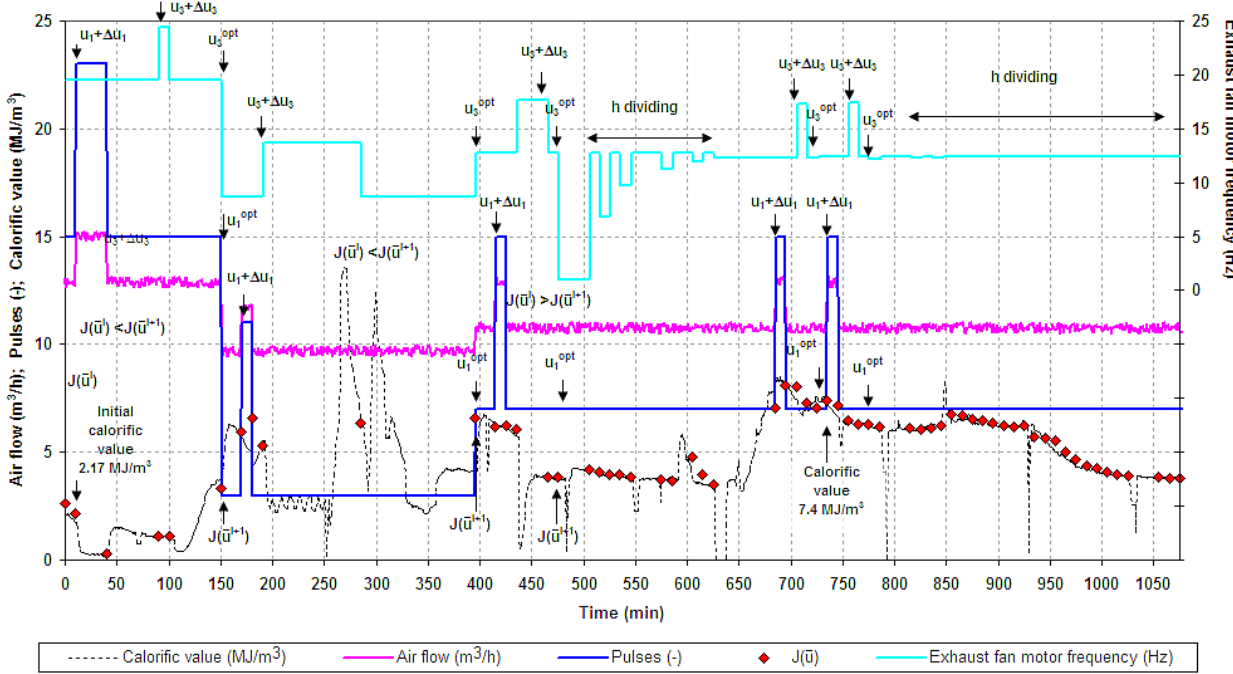
Figure 9. The first test of optimal control with optimization of two parameters.